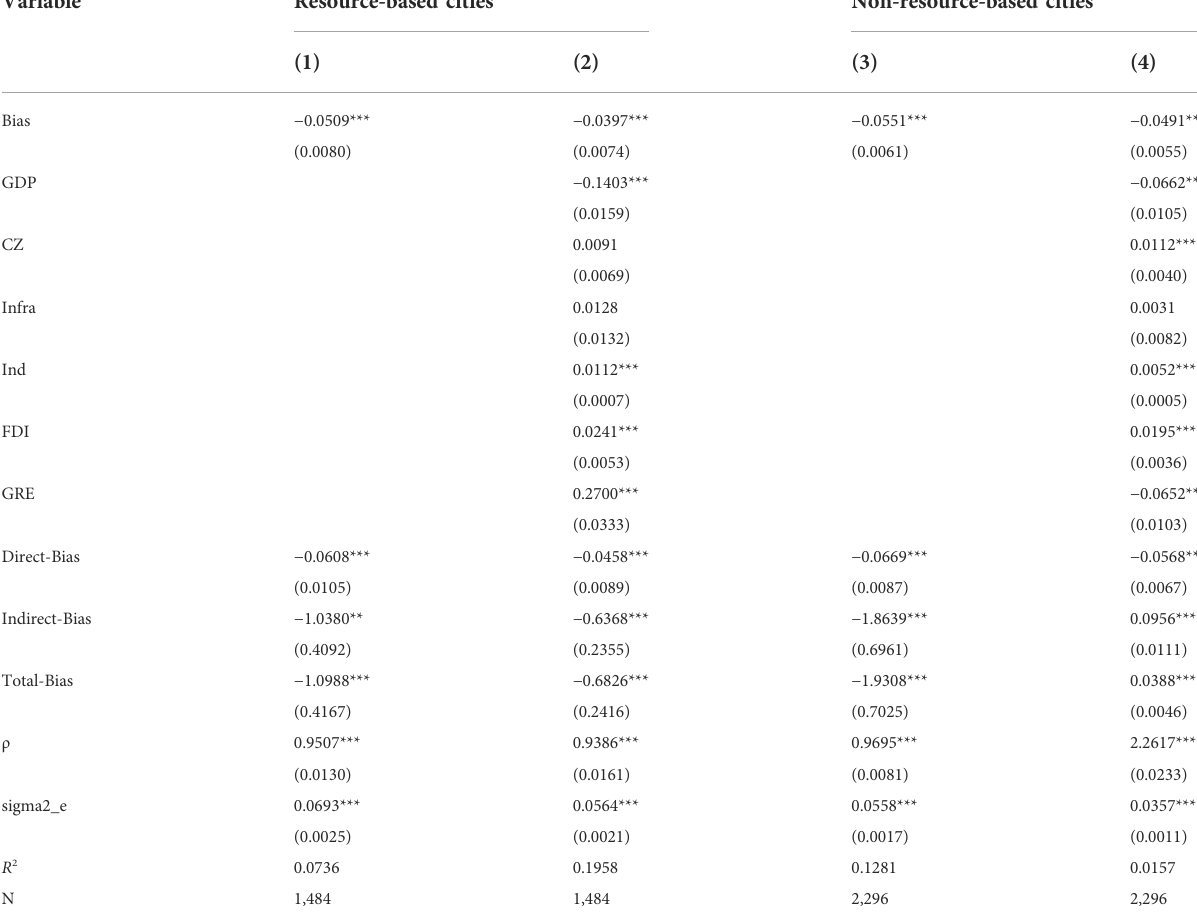
TABLE 10 Heterogeneity of resource-based